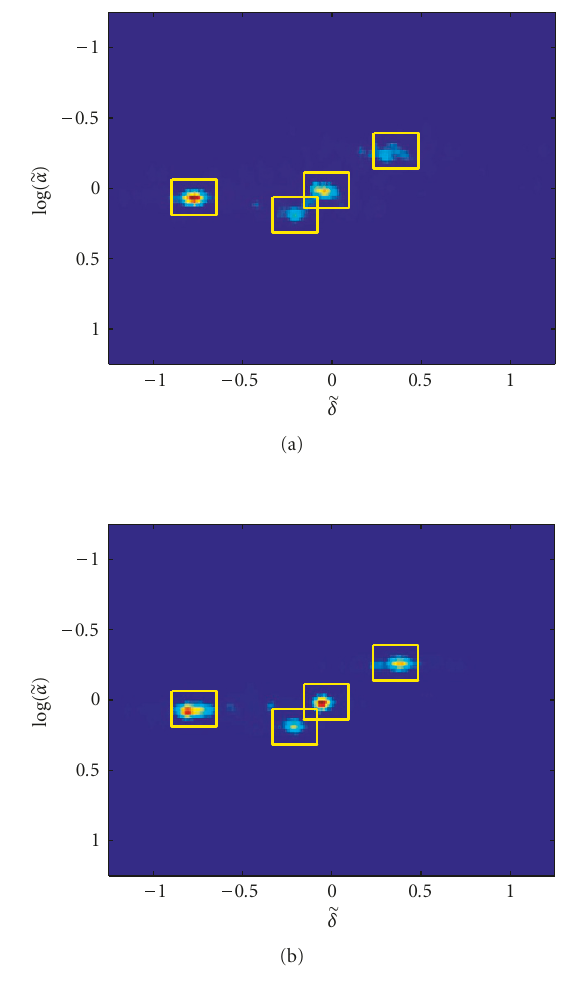
Figure 5: A × D = 100 × 200 histograms for hard DESPRIT (a) and soft DESPRIT (b) have 4 square regions with boundaries de- fined by (cid:2) α = 5 and (cid:2) δ = 10 and centred upon the original mixing parameters.